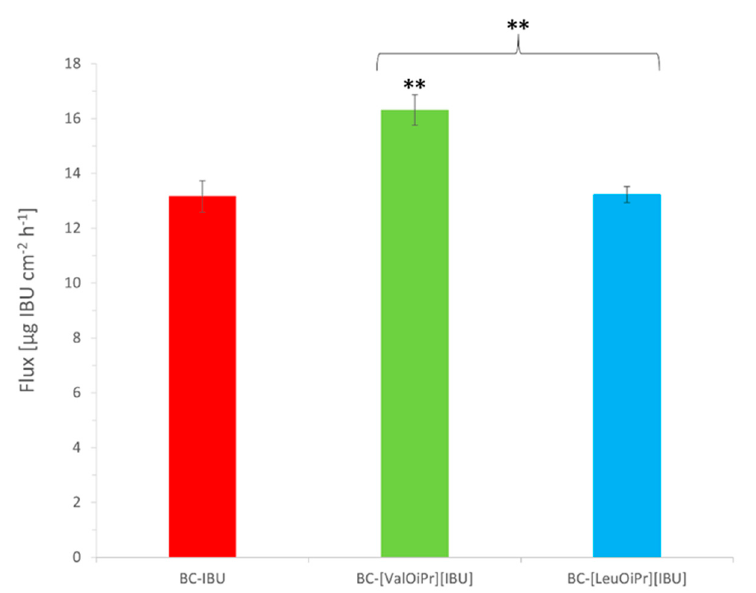
Figure 6. Flux values for ibuprofen permeation from BC membranes. Mean values ± standard deviation, n = 3. Statistically significant difference from BC-IBU was estimated using the ANOVA test. Double asterisk ** means statistical difference for p < 0.01. Brace { means statistical difference between two ibuprofenate salts. Table 2. Average cumulated mass after 24 h permeation of IBU, [ValOiPr][IBU], and [LeuOiPr][IBU] permeated from bacterial cellulose into acceptor fluid pH 7.4 Mean values ± standard deviation, n = 3.